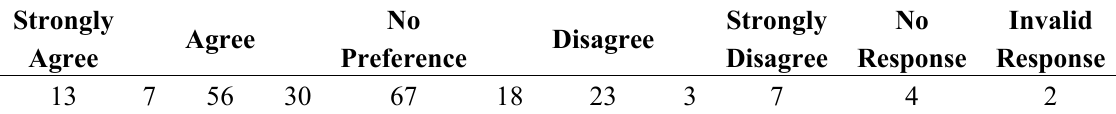
Table 14. Responses to the statement “As an editor for a journal, I would publish an article with computer-generated findings”.